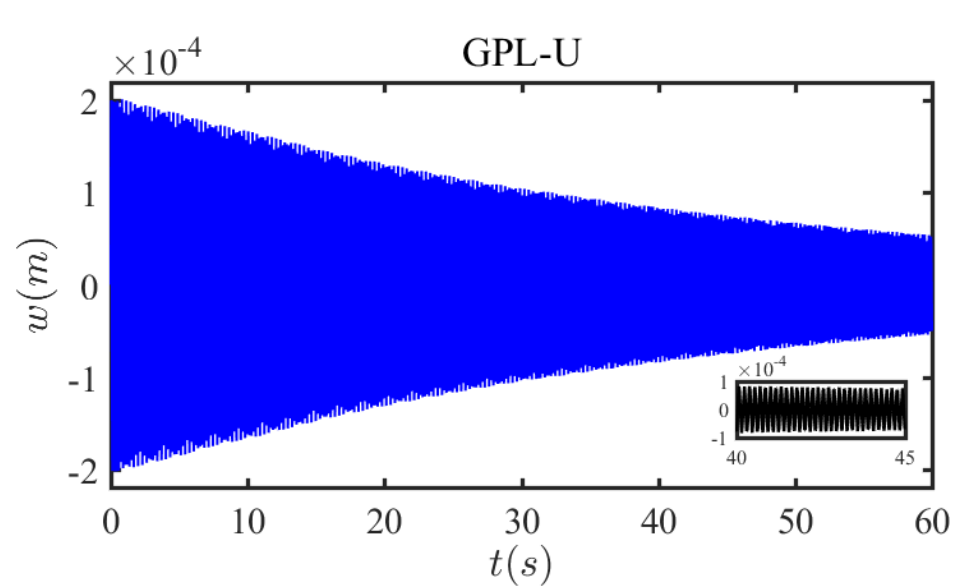
‐ ‐ Figure 3. The fundamental variation frequency of pipes conveying fluid frequency versus flow